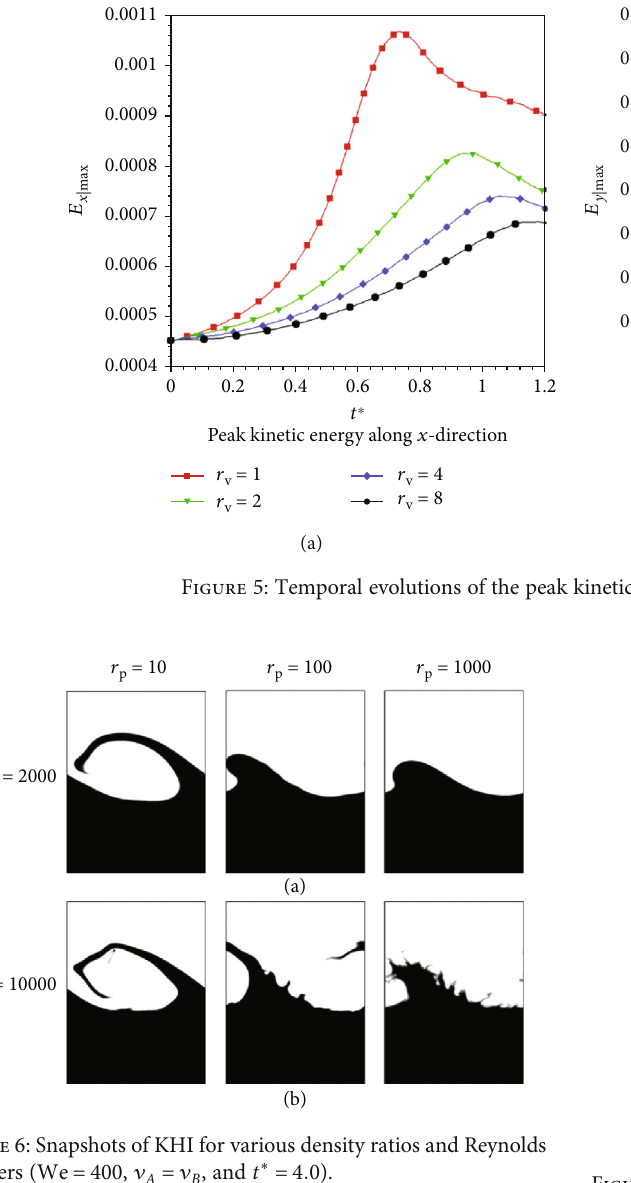
7: Averaged order parameter pro fi les against the y-direction at di ff erent dimensionless times ( Re = 2000 , We = 400 , and r ρ = 10 ). Table 1: Widths of the mixing layer for di ff erent density ratios and Reynolds